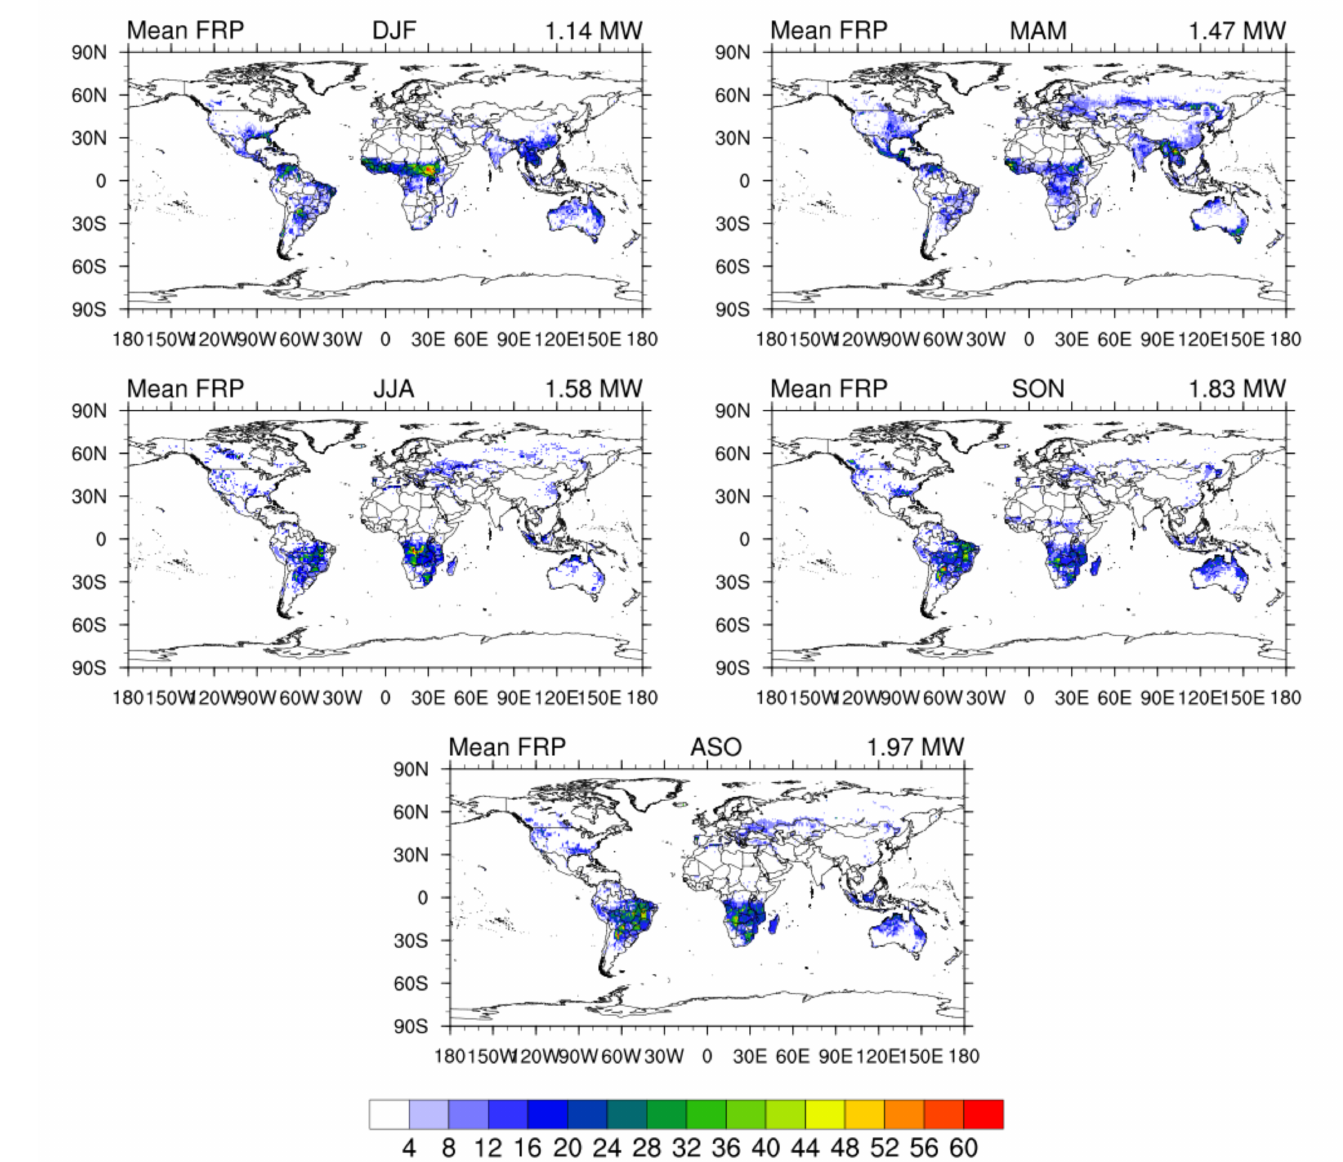
Figure 13. Seasonal mean fire radiative power (FRP) detected by the MODIS sensor with AQUA active fire products over the globe during DJF, MAM, JJA, SON and ASO from 2010 to